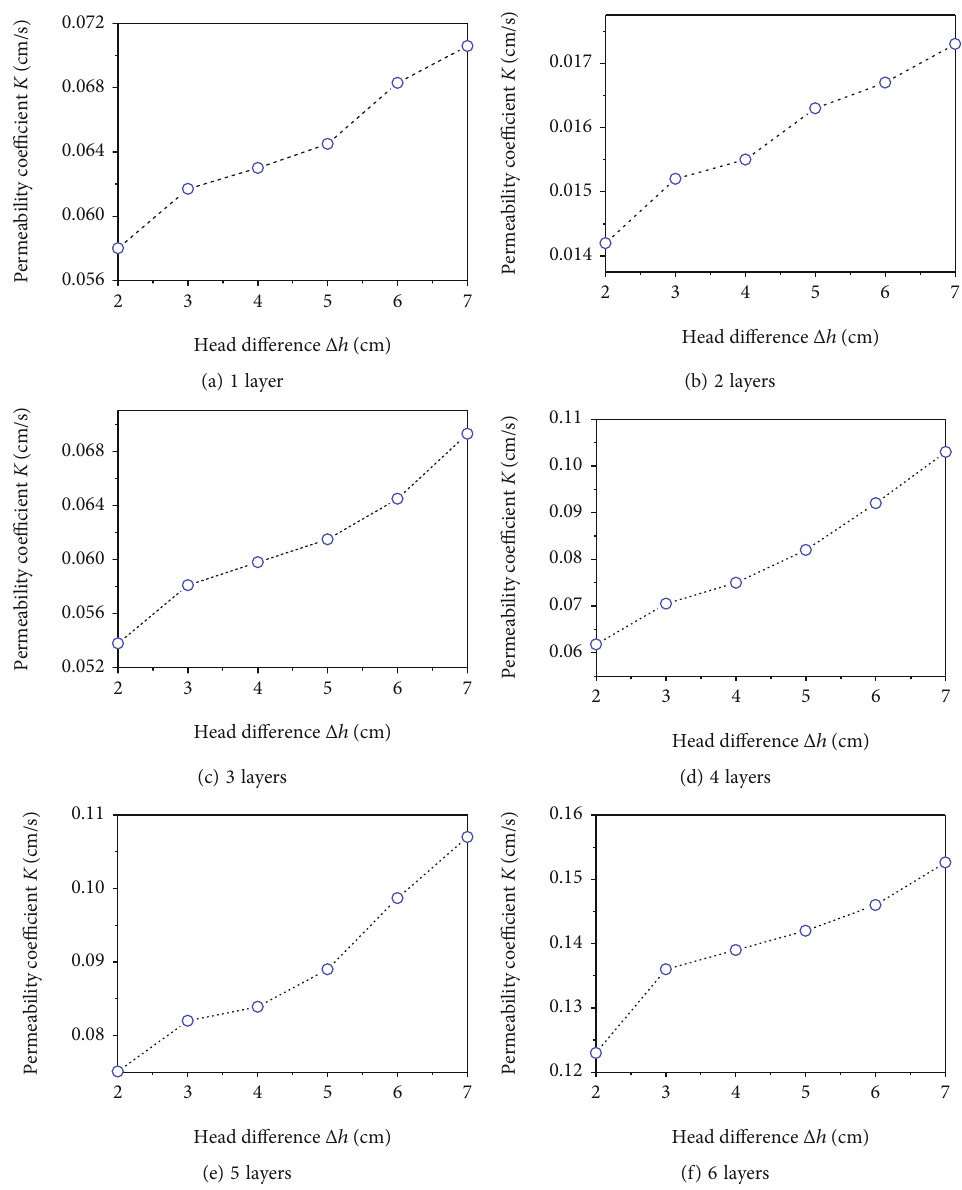
Figure 16: Variation of the permeability coe ffi cient of the slotted tube overlap geotextile layers under di ff erent head di ff erence.